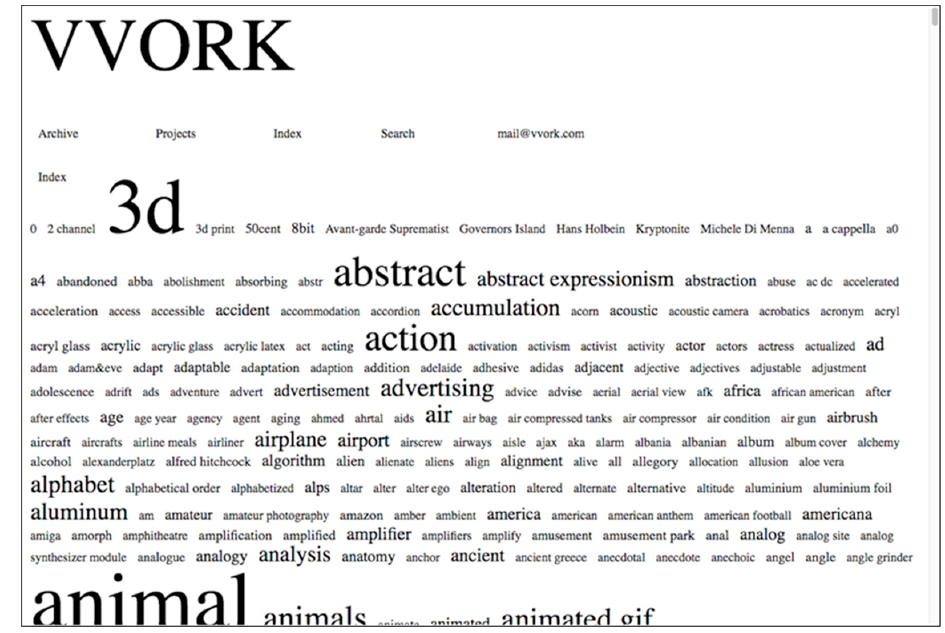
Figure 6. VVORK , 2006–2012. Screenshot of index page, 2019. @ VVORK, 2019.